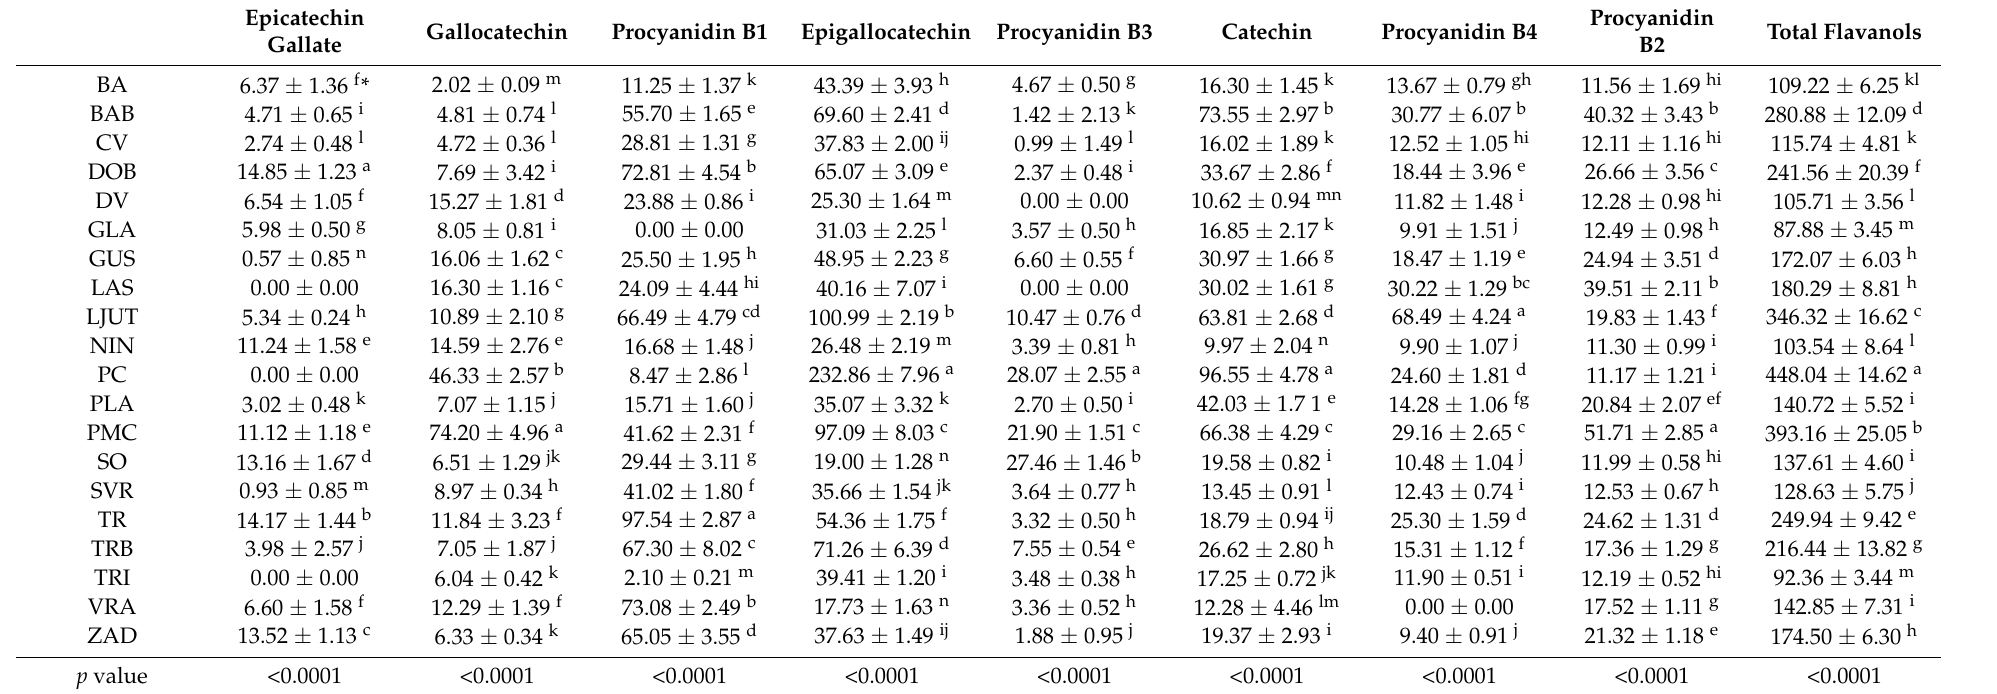
Table 3. Flavanols profile of Croatian autochthonous grape